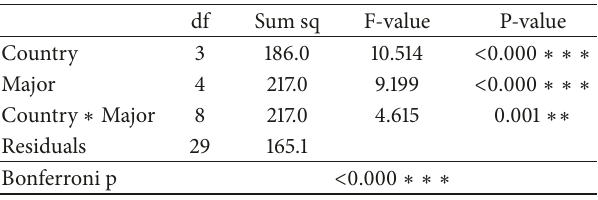
Table 4: Two-way ANOVA analysis